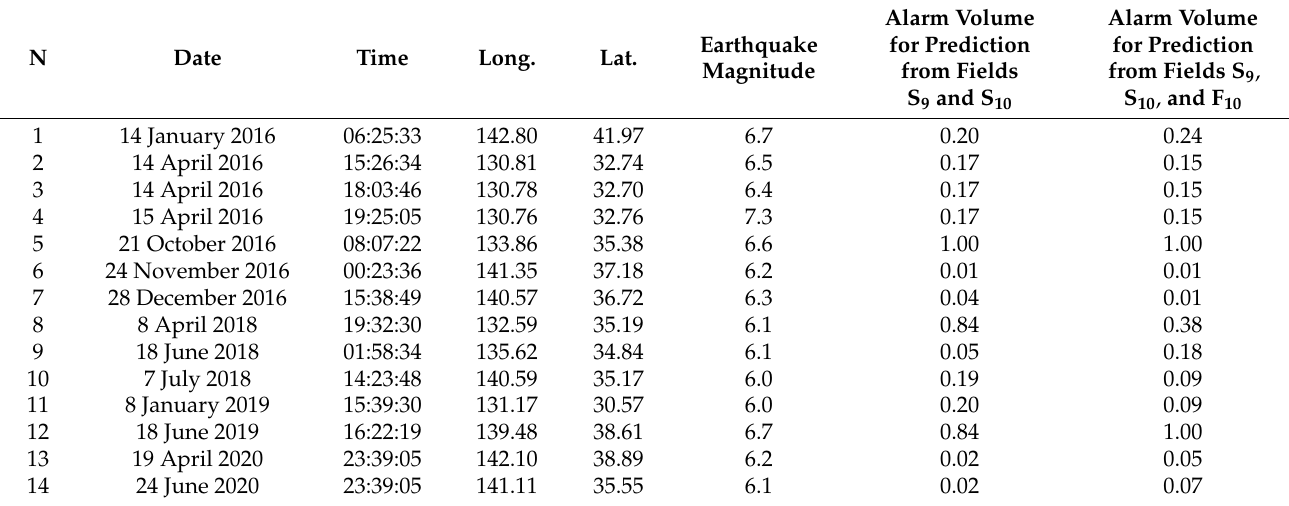
Table 5. Japan. Results of forecasting earthquakes with magnitudes m ≥ 6.0 from seismological fields and from the same fields together with the GPS field.